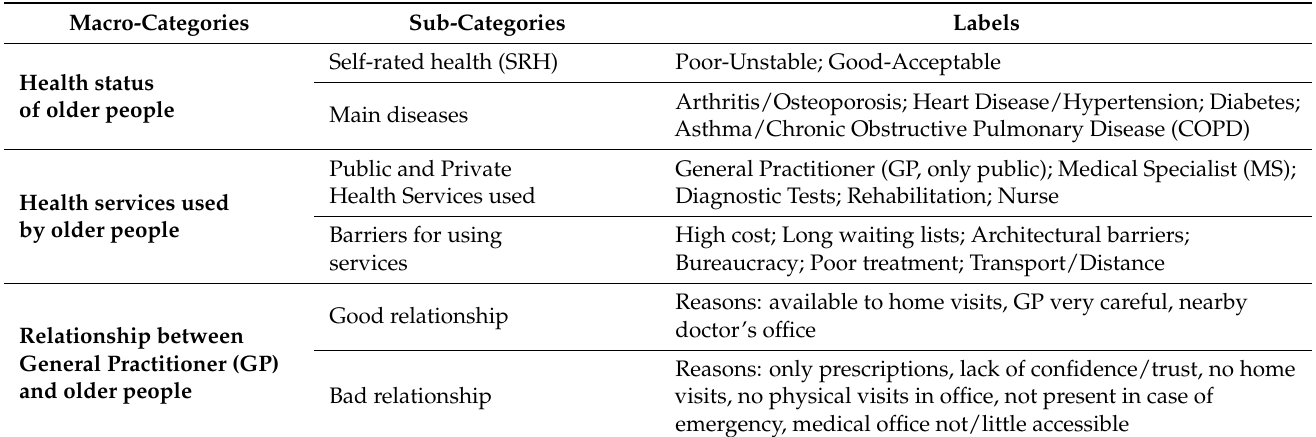
Table 1. Macro-Categories, Sub-Categories and